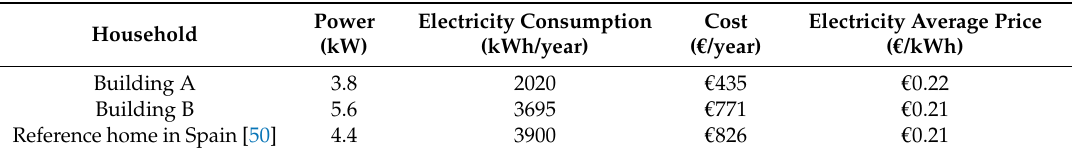
Table 6. Comparison between the electrical consumption and economic cost in a household of four people in the buildings analysed and in an average reference